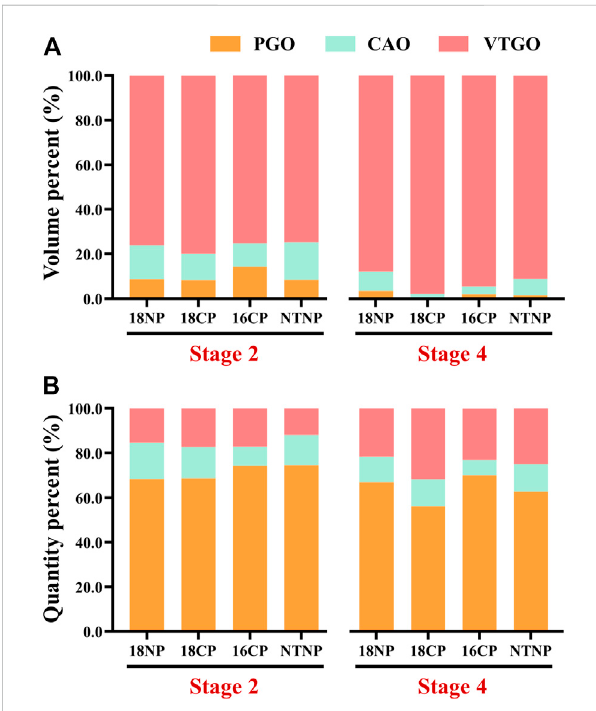
FIGURE 8 Volume and quantity percentage of primary growth stage oocytes(PGO),corticalalveolistageoocytes(CAO),andvitellogenesis stage oocytes (VTGO) of largemouth bass. (A) Volume percentage of PGO, CAO, and VTGO relative to the total volume of all oocytes. (B) Quantity percentage of PGO, CAO, and VTGO relative to the total number of all oocytes. Stage 2 , supposed maturation of ovary, right after temperature increase, 25 September . Stage 4 , the supposed spawning peak, spawning was observed in all treatment groups, 21 November. 18NP , 18 ° C overwintering water temperature, natural photoperiod group. 18CP , 18 ° C overwintering water temperature, controlled photoperiod group. 16CP , 16 ° C overwintering water temperature, controlled photoperiod group. NTNP , natural water temperature and natural photoperiod group. N =